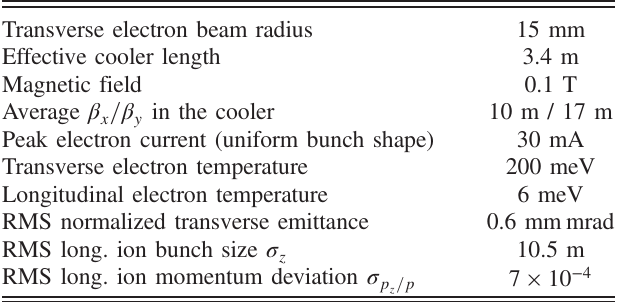
TABLE IV. Cooling simulation parameters.